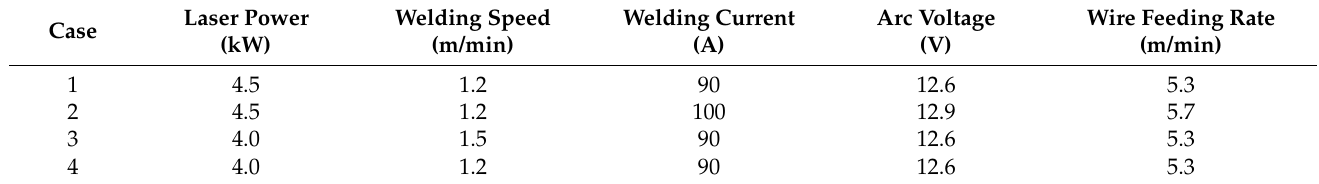
Table 2. Process parameters during hybrid laser arc